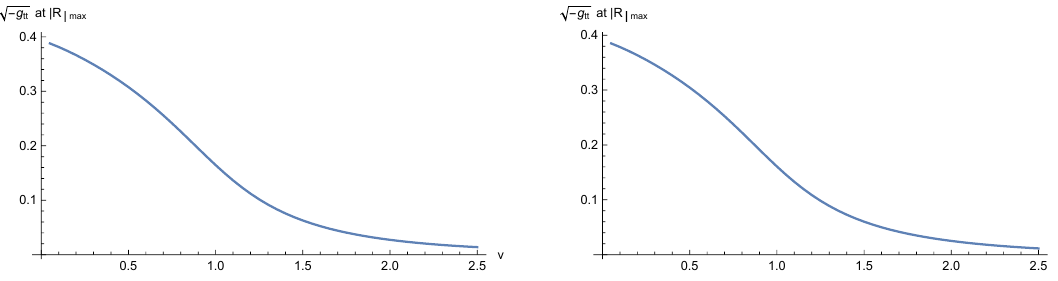
√ Figure 13 . Plots showing the value of − g tt at the position of the maximum absolute value of the Ricci scalar against flow time λ for the same flows as in the previous figure. The lefthand plot corresponds to the negative sign perturbation, the right to that with positive sign. Both exhibit a very similar behaviour, with the maximum closely approaching the horizon as the flow